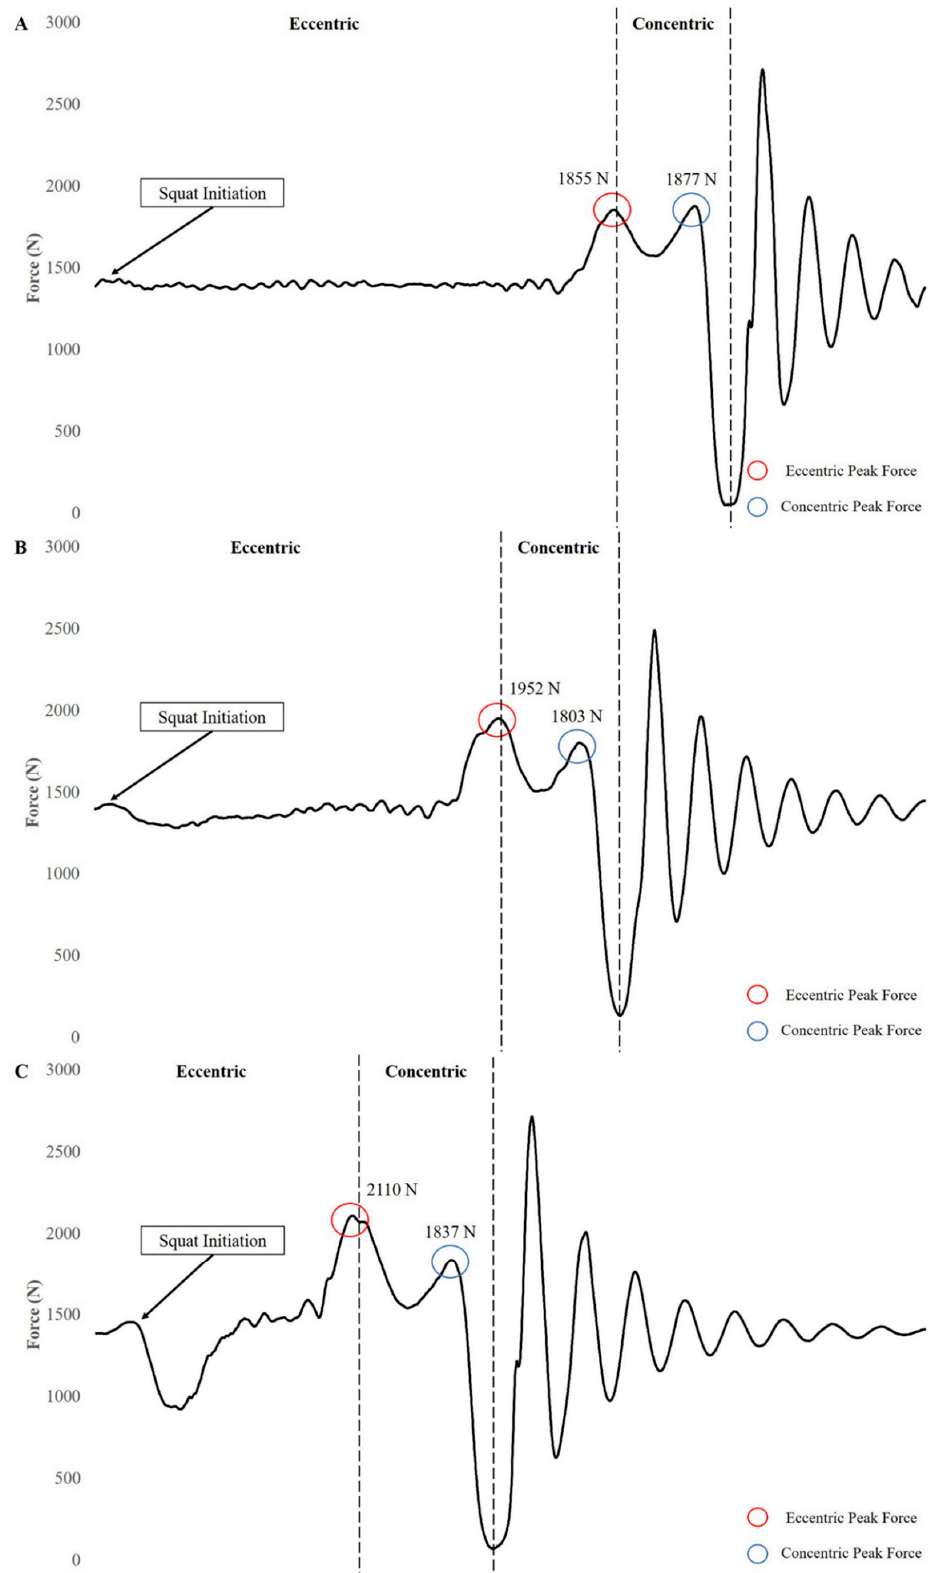
Figure 1. Force-time curves of a four-second tempo ( A ), two-second tempo ( B ), and traditional ( C ) back squat performed with 70 kg by a healthy, 31 year old male.